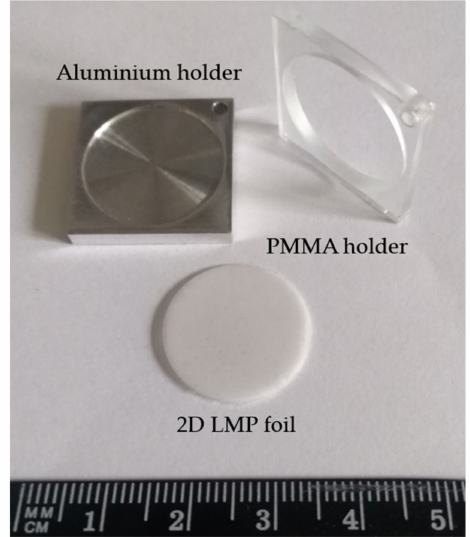
Figure 1. The prototypes of the 2D LMP flat sheet silicone foil of a size of 20 ( ± 0.1) mm in diameter and 0.54 ( ± 0.3) mm thickness produced at the special aluminum holder (upper left corner) by homogeneously mixing the self-synthesized LMP powder into the SYLGARD ® 184 silicone elastomer matrix at a 1:2 weight ratio. Additionally, on the right-hand side, 1 of the 10 PMMA holders with a hole of a size of LMP foil, used for proton irradiation, is shown.